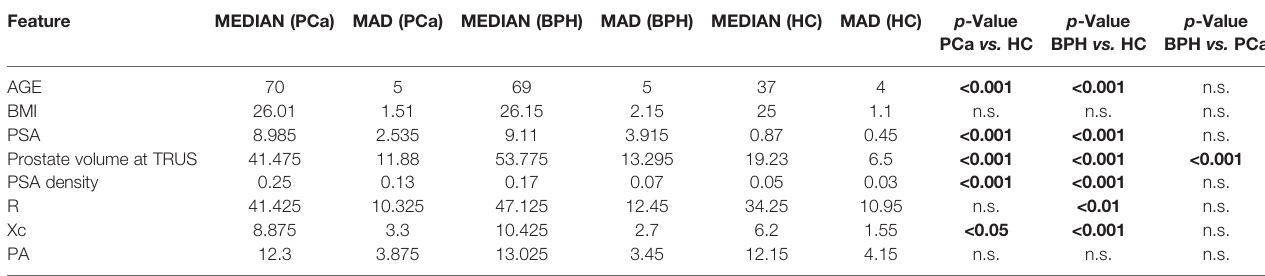
TABLE 2 | Statistical comparison between patients who underwent to prostate biopsy (cancer and BPH) and controls. Feature